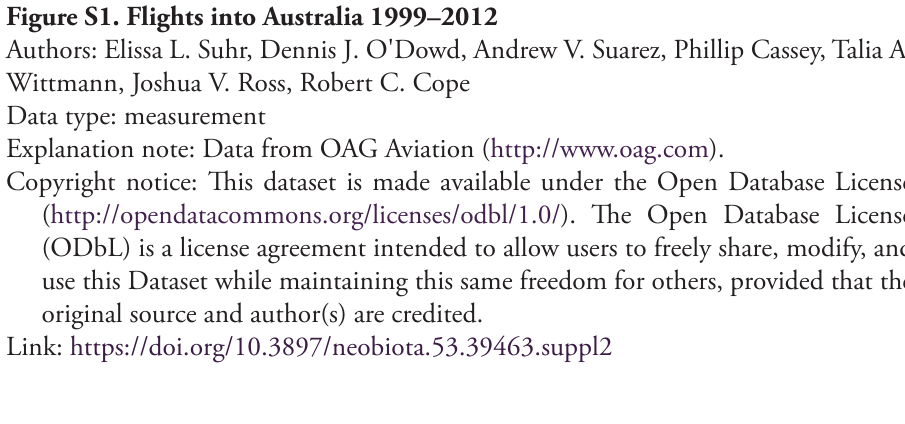
Figure S2. Ant interception records into Australia separated by transportation type (aircraft, sea vessel or other) and source bioregion